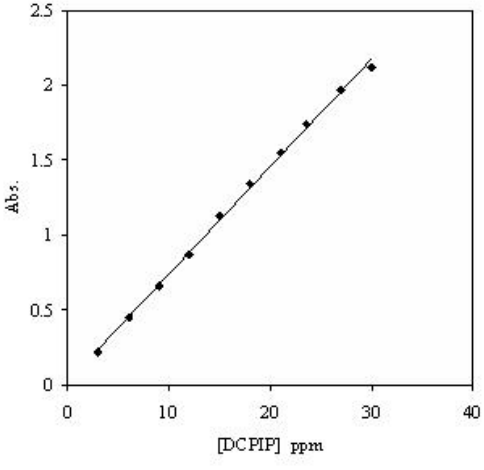
Fig. 2 Variation of absorbance with concentration of